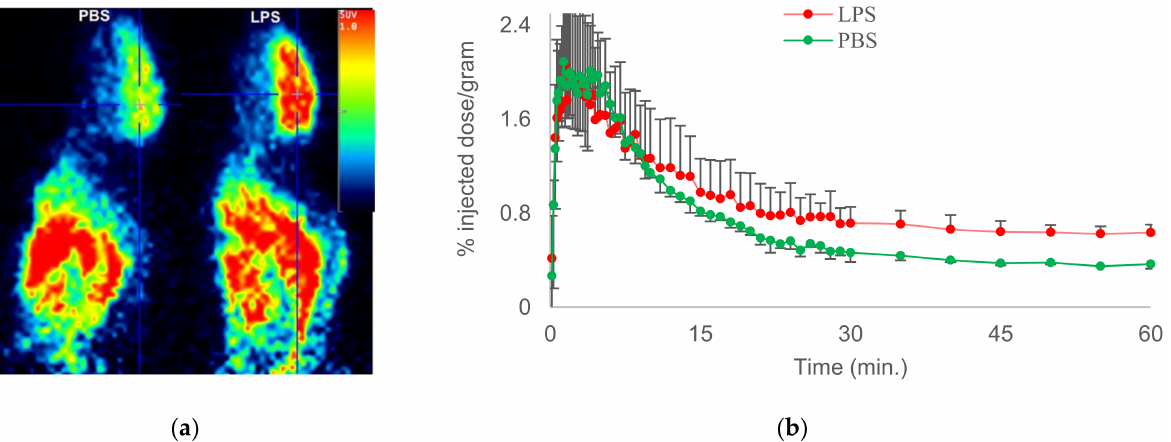
Figure 3. Representative microPET images of [18F]MTP in PBS- and LPS-administered mice ( a ); TACs of [18F]MTP in PBS- (green) and LPS (red)-treated mice ( b